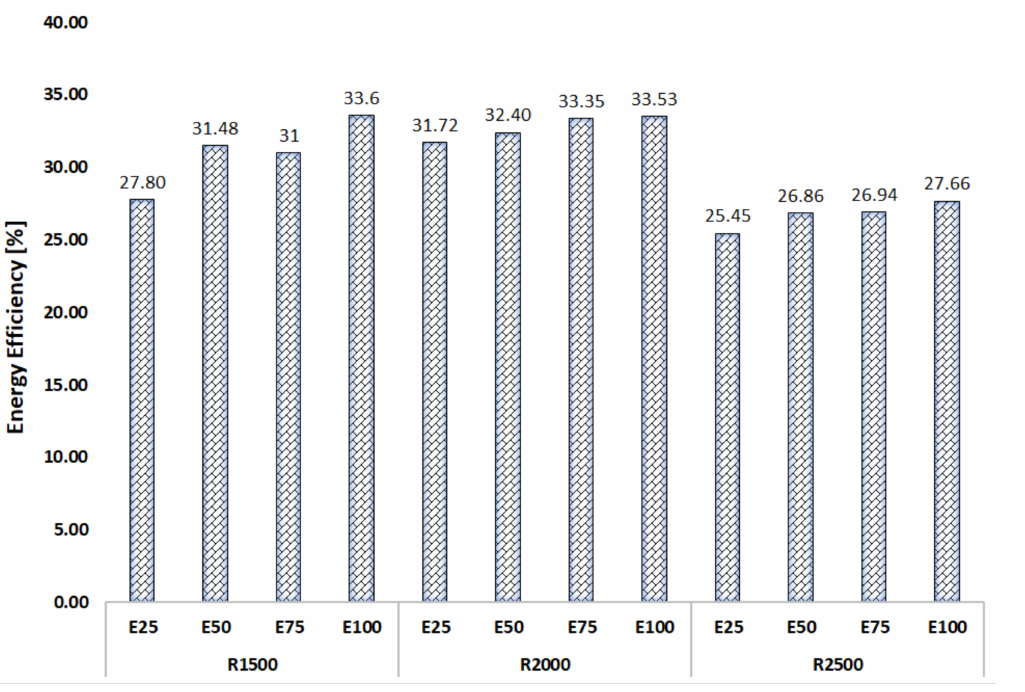
Figure 3. Energy efficiency vs. fuels and engine speeds